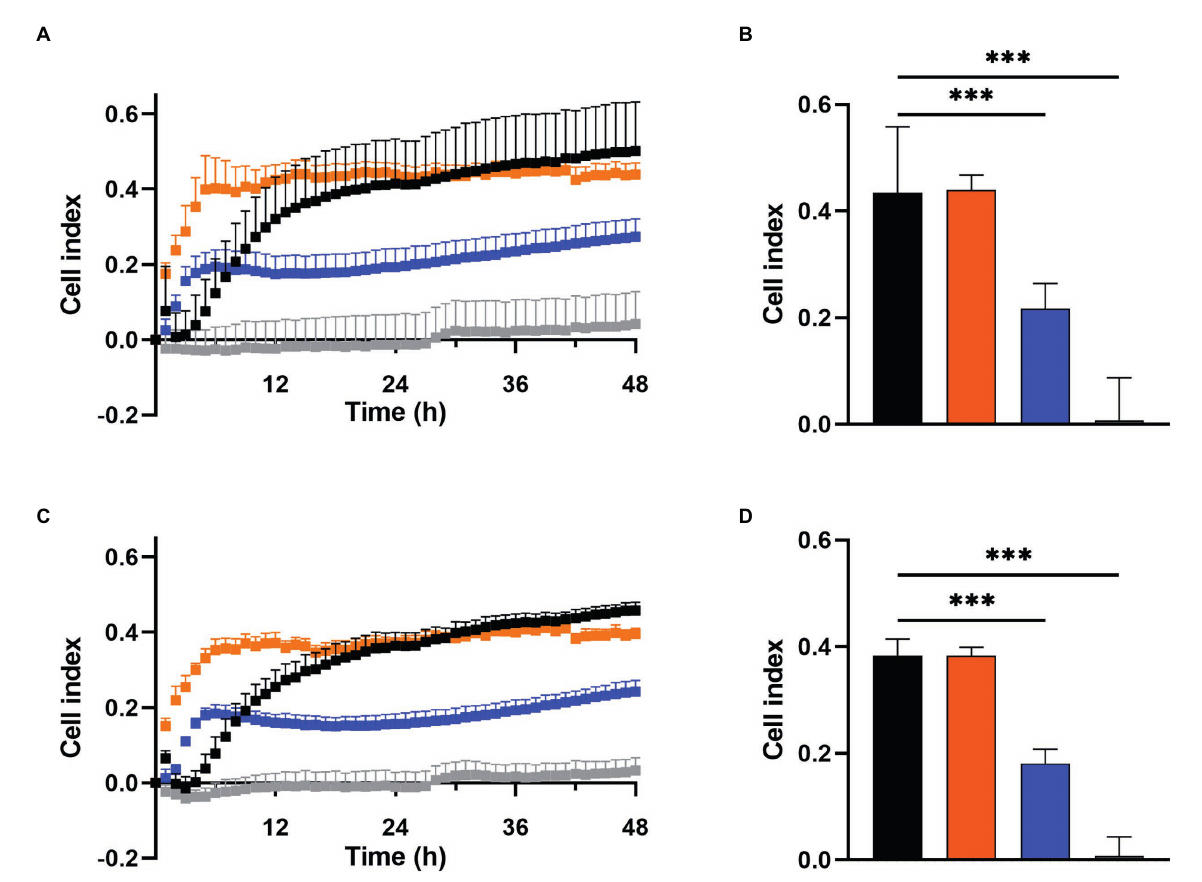
FIGURE 3 Effect of 8 μ g/ml diethyldithiocarbamate (DDC; orange), 32 μ g/ml Cu 2+ (blue) and combined DDC-Cu 2+ (grey) on (A) the cell index of MRSA Mu50 and (C) S. epidermidis ATCC 35984 over 48 h compared to the untreated control (black). Comparison of the mean cell index between 12 and 48 h for each treatment of (B) MRSA Mu50 and (D) S. epidermidis ATCC 35984 ( n > 3; *** p <